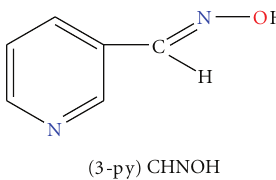
Scheme 1: Structural formula and abbreviation of the ligand employed in this